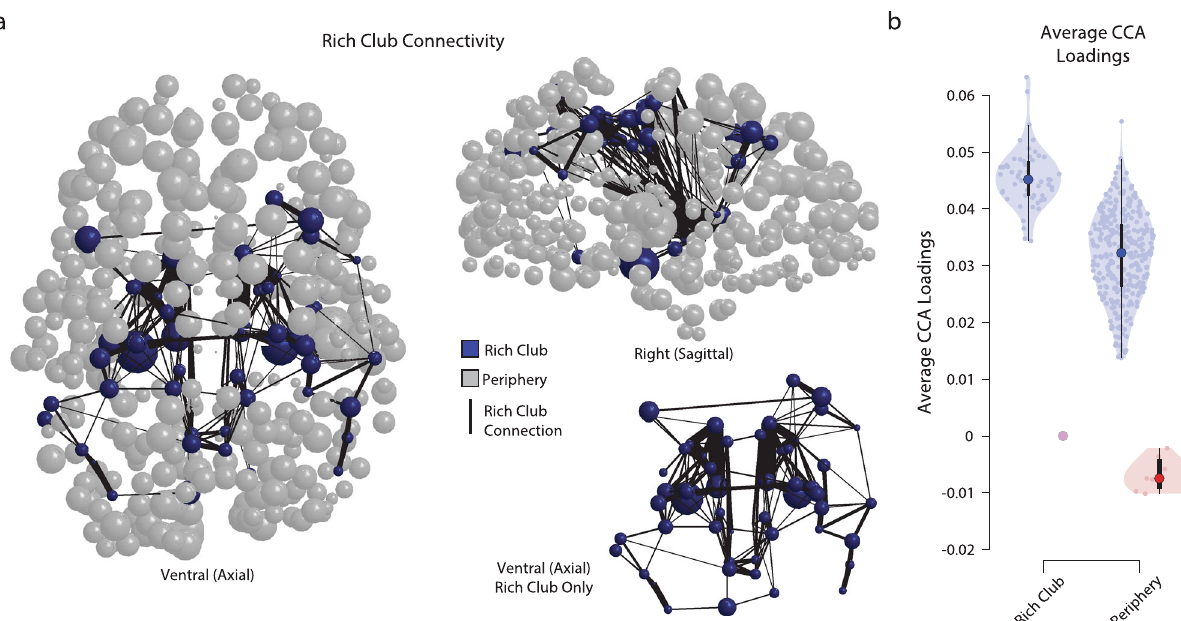
Fig. 4 Relationship between the brain connectome rich-club and the contribution to the CCA. a A ball-stick representation of the rich club scaled by CCA loadings. Axial and sagittal views of the relation between rich club and CCA loadings. Each brain region is displayed as a sphere. Blue spheres are part of the core rich-club. Gray spheres are part of the periphery of the rich-club. The diameter of each sphere was scaled by cross-validated CA 1 loading in M 1 . The black lines show connections between rich-club nodes. The thicker the line, the higher the average streamline density. The right-hand bottom ball-stick representation shows an axial view of the rich-club nodes and connections isolated from the periphery. b The average CA 1 loading across rich-club core and periphery. Positive and negative CA 1 loadings for rich-club core and the periphery (violin plots report the full underlying distributions of the parameters from CA 1